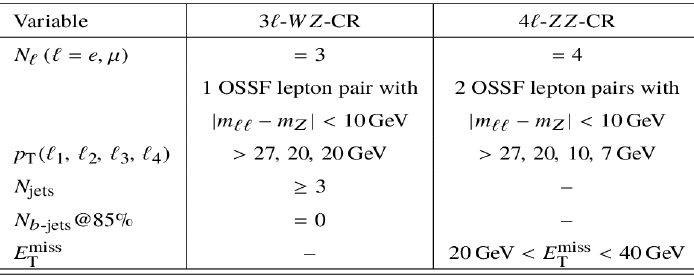
Figure 2. ATLAS control regions [11].